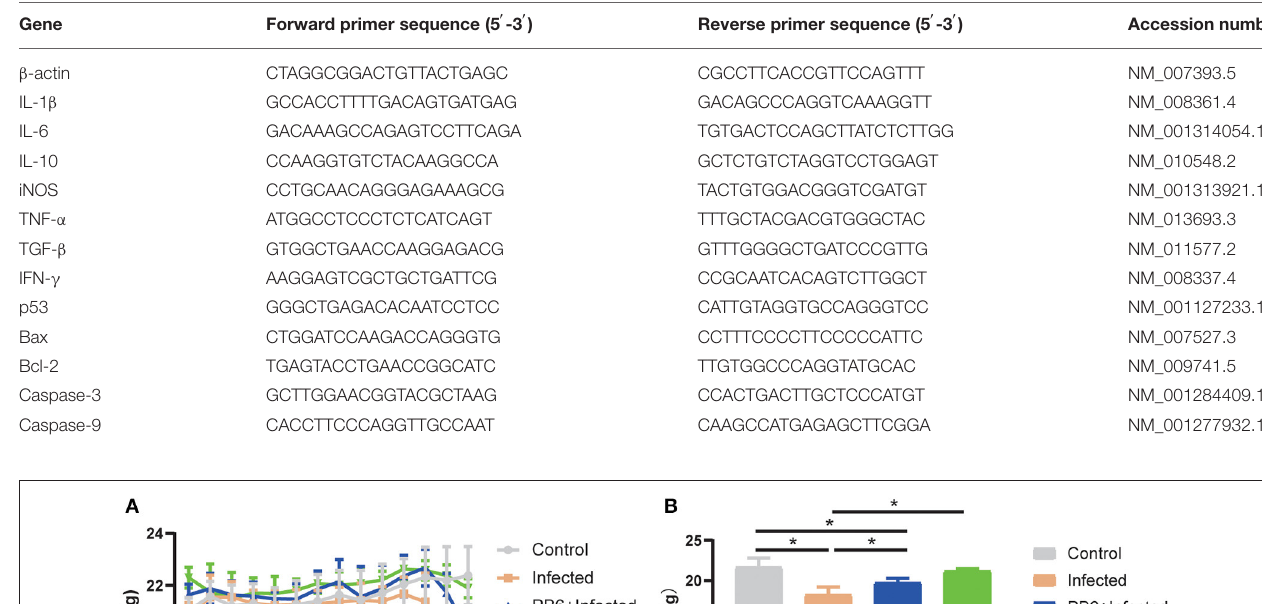
TABLE 1 | Primer sequences for qPCR.